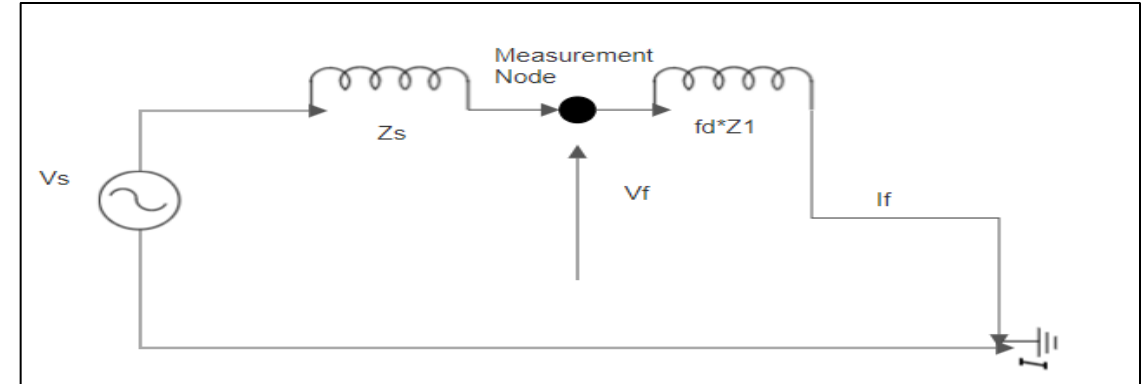
Figure 7. Impedance-based method.